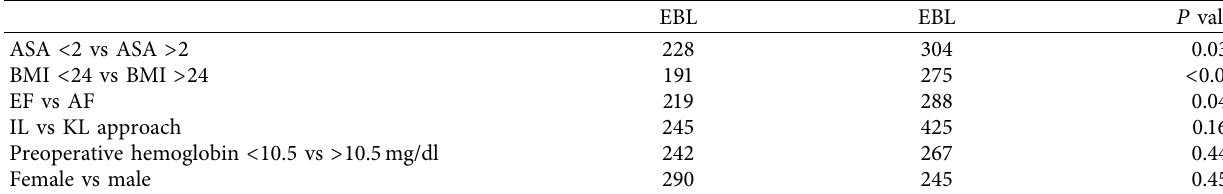
Table 3: Average EBL was analyzed for associations with ASA < 2 vs ASA > 2, BMI < 24 vs BMI > 24, elementary or associated fracture pattern, surgical approach, preoperative hemoglobin < 10.5 vs > 10.5mg/dl, and gender. Patients with an ASA > 2, BMI > 24, and associated fracture patterns were associated with increased intraoperative blood loss. Surgical approach, postoperative hemoglobin, nor gender was associated with increased intraoperative blood loss. � Ilioinguinal, KL � Kocher-Langenbeck, ASA � American Society of